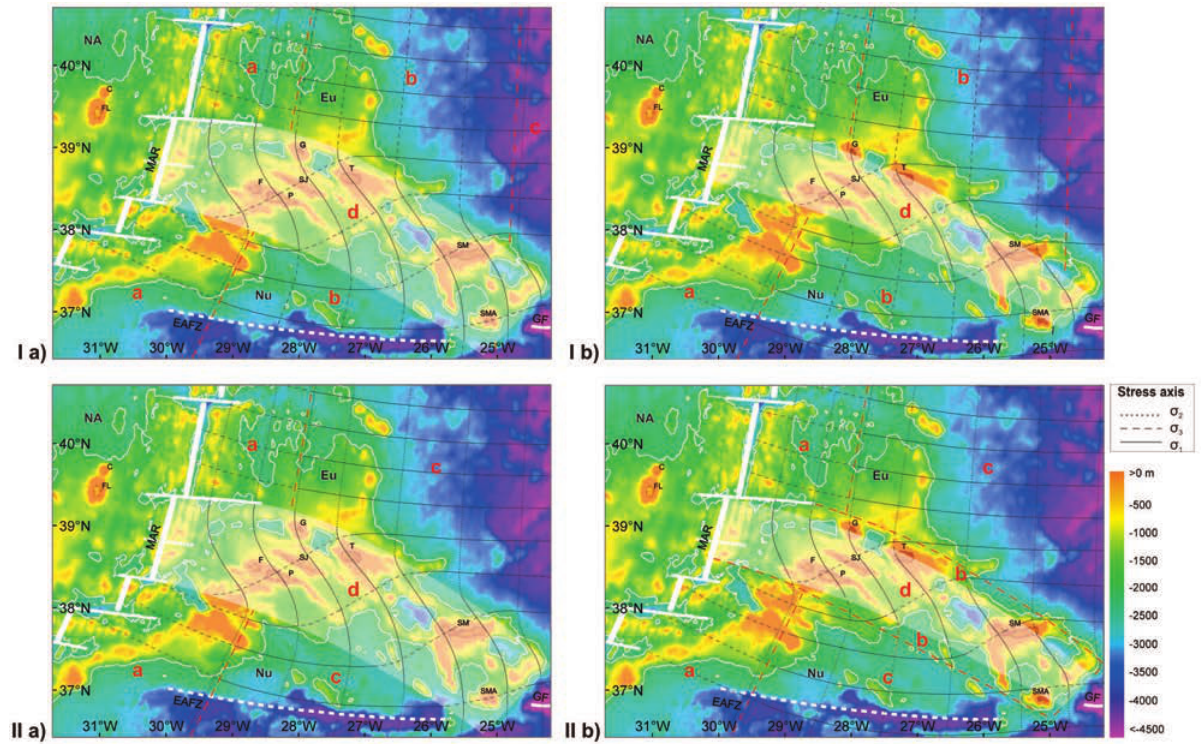
Figure 15. Estimated trajectories of the main stress axis in the western segment of the Eu-Nu plate boundary. Above – hypothesis (1): the tensile stress field (a) close to the MAR passes laterally to transtensive (b) with the establishment of a transition stress field. Eastward, fur- ther away from the ridge, permutation of σ 3 with σ 2 occurs as a region in compression is entered (c). Inside the sheared region (d) stress permutation and deviation of stress trajectories occur. Ia) Stages of widened shear zone; Ib) Stages of narrowed shear zone: the islands near the edges of the sheared interplate region are subjected to the stress field b. Below – hypothesis (2): the tensile stress field (a) close to the MAR passes laterally to compressive (c) as the sea-floor moves away from the ridge. Inside the sheared region (d) stress permutation and deviation of the stress trajectories occur. During stages of narrowing of the sheared region, permutation between σ 2 and σ 3 may originate a local in- termediate stress field (b). IIa) Stages of widened shear zone; IIb) Stages of narrowed shear zone: the islands near edges of the sheared in- terplate region are subjected to the stress field b. Red dashed lines separate the different stress field domains; white shaded area represents the interplate sheared region. Trajectories of maximum tensile stress axis near the MAR are based on the spreading direction of NA-Eu ac- cording to the NUVEL-1A (DeMets et al. 1994). Trajectories of the main stresses within the sheared zone are based on neotectonic data from emerged areas [e.g. Madeira and Brum da Silveira 2003, Carmo 2004, Hipólito 2009, and the present work]. Acronyms as in Figure1. Ba- thymetry adapted from Lourenço et al. [1997]. Datum: WGS 1984.